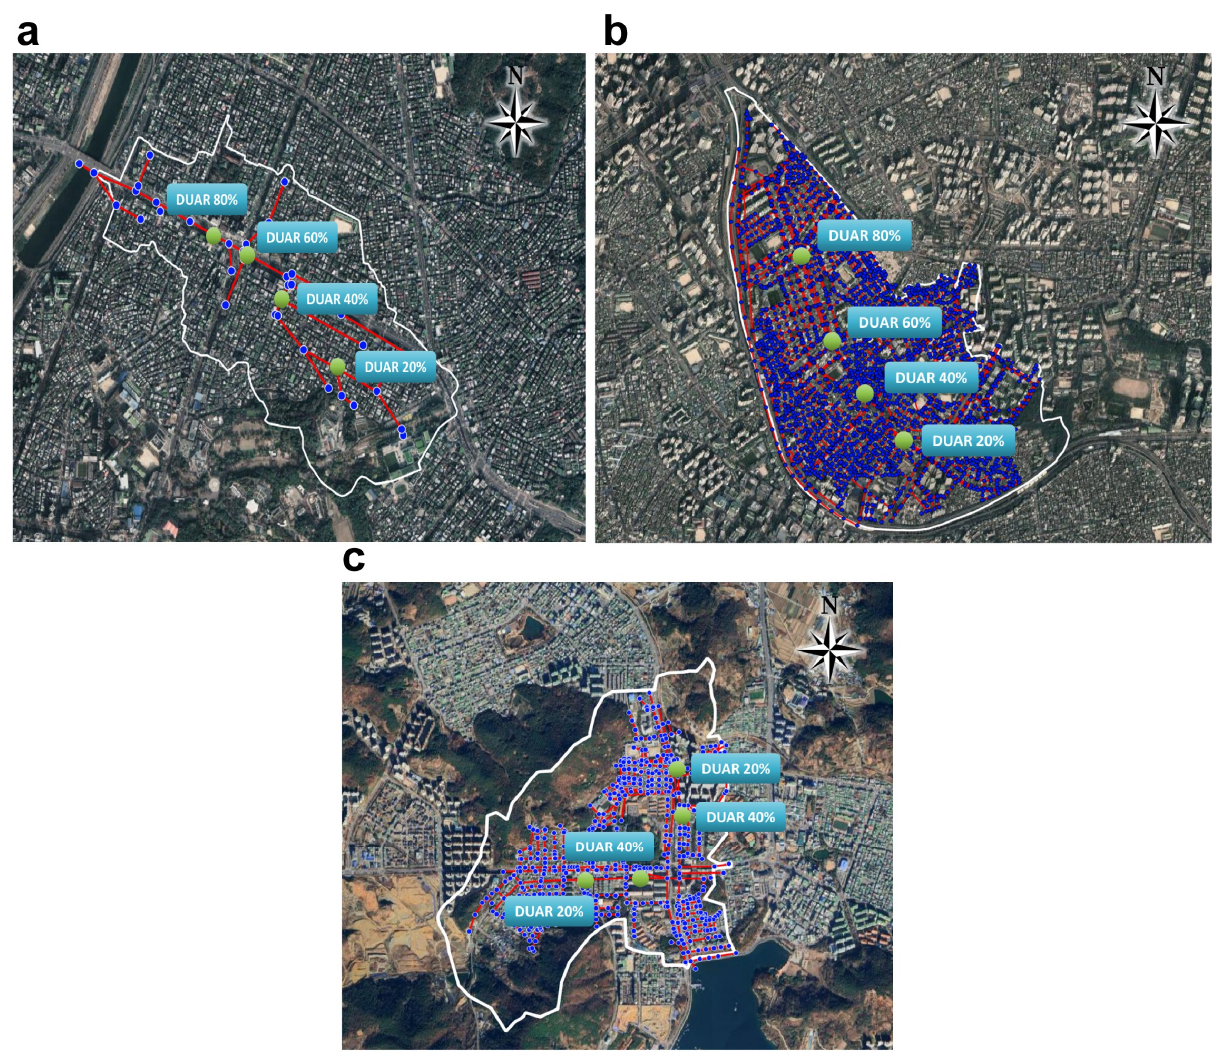
Figure 10. Location of the trunk drainage sewer system in the ( a ) Gunja, ( b ) Dorim, and ( c ) Dowon watersheds.